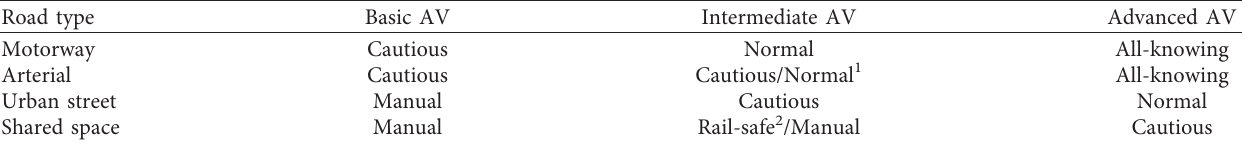
Table 1: Specification of the driving logics envisioned for the three AV classes in the different road environments for cars. Road